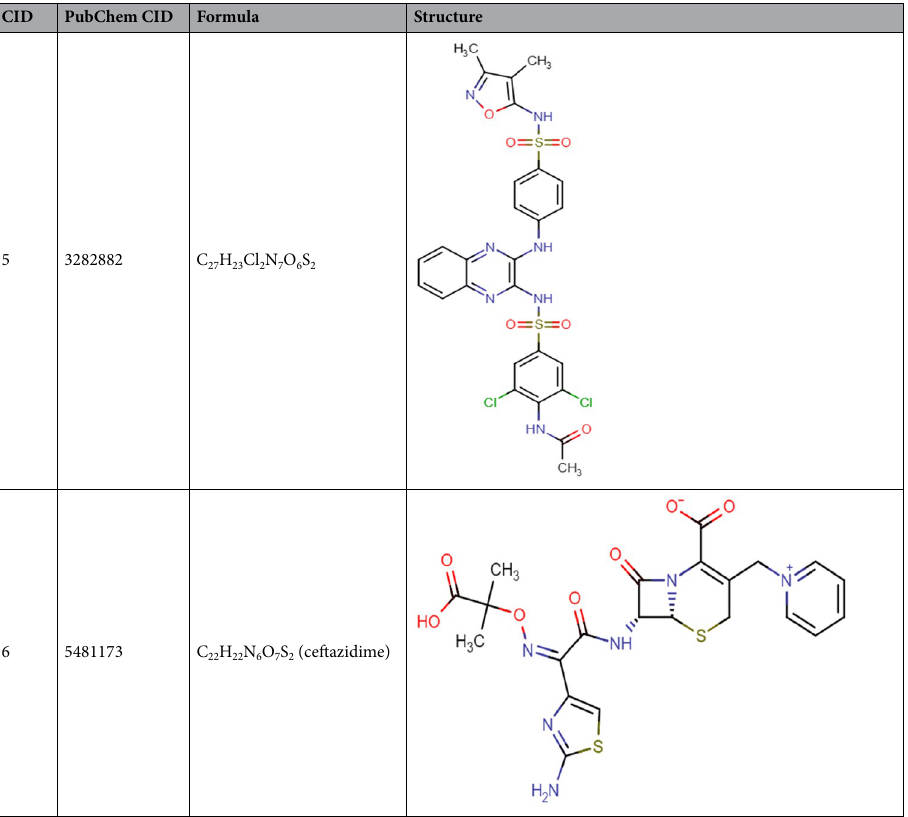
Table 1. The 2D structures, PubChem CIDs, and formulae of the best docked compounds and the control compound